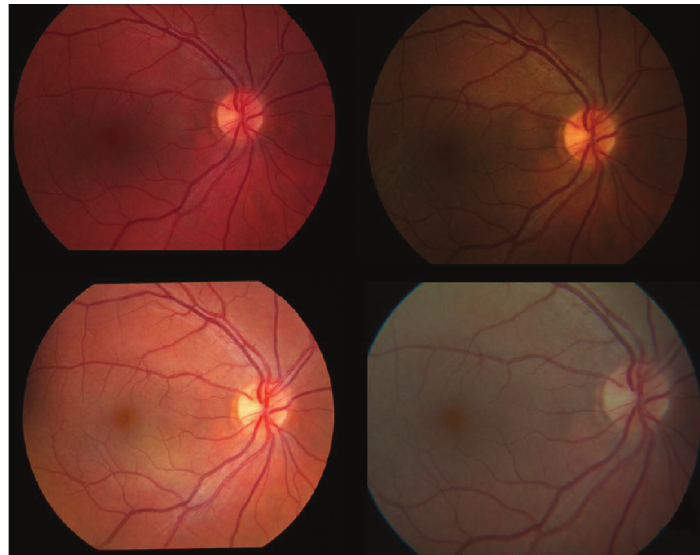
Figure 1: Examples of the variation of color among fundus images of the same retina.